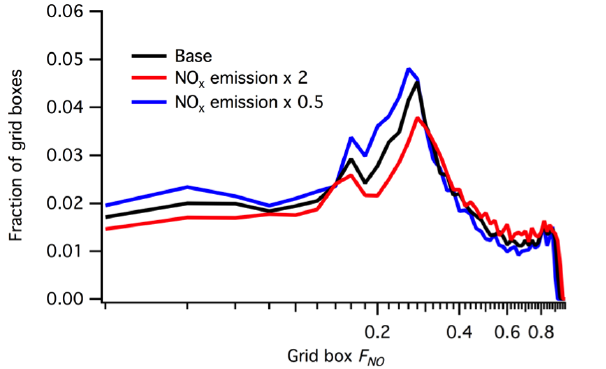
Figure 8. Oxidisable bond loss mechanism fractions under chang- ing effective CH 4 emissions (0.5 × CH 4 concentration field, base simulation and 2 × CH 4 concentration